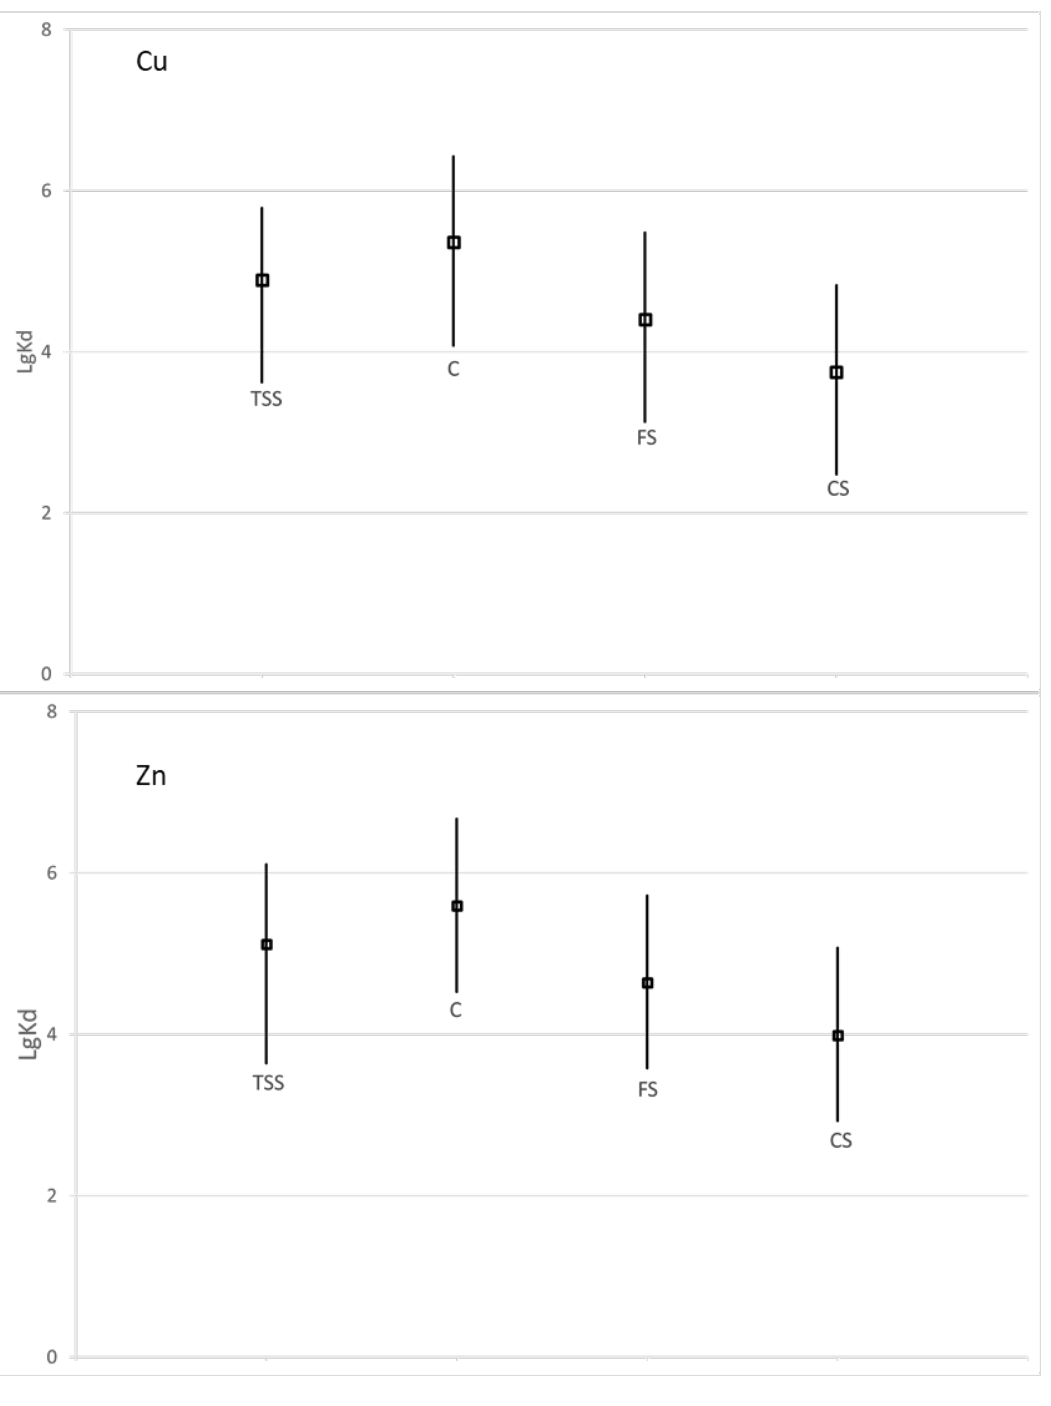
Figure 9. Partitioning coefficients (lgKd) of Cu (upper graph) and Zn (lower graph) for TSS (total suspended sediment), C (clays), FS (fine silts) and CS (coarse silts), with average values represented by squares. The Cu and Zn lgKd values in some rivers of the world range from 3.9 to 6.3, 3.9 to 8.5, respectively (Table